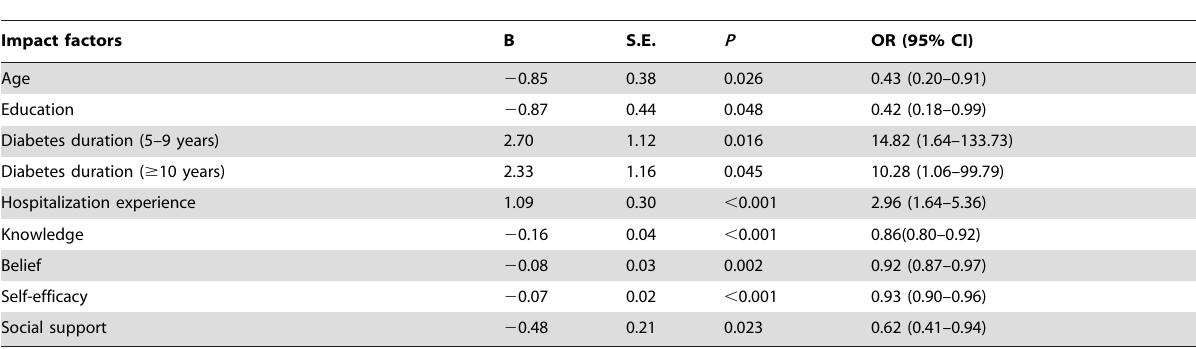
Table 5. Multiple-factor analysis of self-management